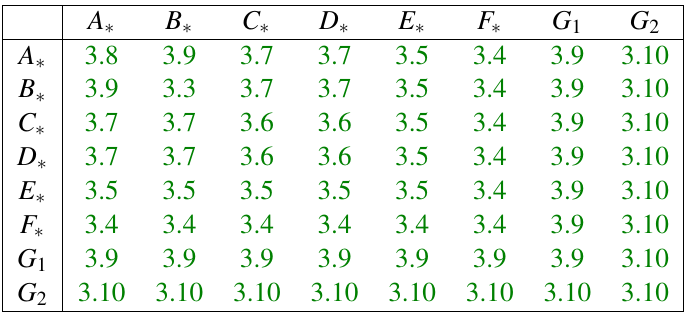
Table 1: References to the subsections where the corresponding tiles are